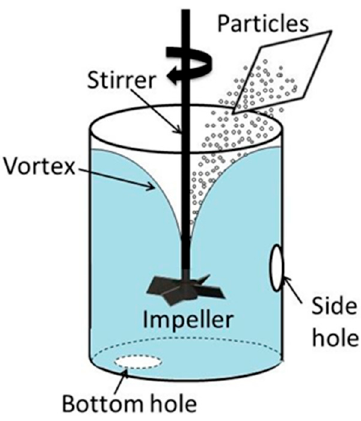
Figure 1. A schematic representation of the experimental setup. The impeller was positioned vertically at the vessel axis in such a way that the distance between its blades’ lower edges and the vessel bottom was 80 mm. The impeller diameter (distance between the opposite tips of impeller blades) was 50 mm.